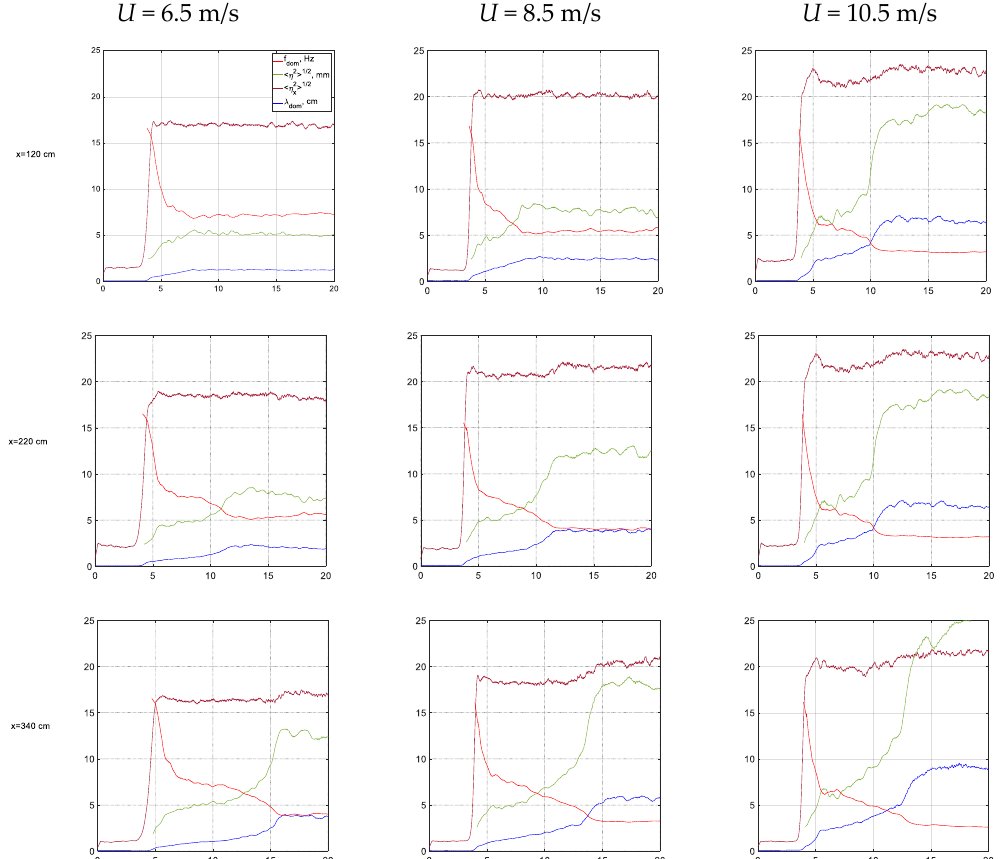
Figure 23. The ensemble-averaged wave parameters as a function of time elapsed since the activation of the blower.